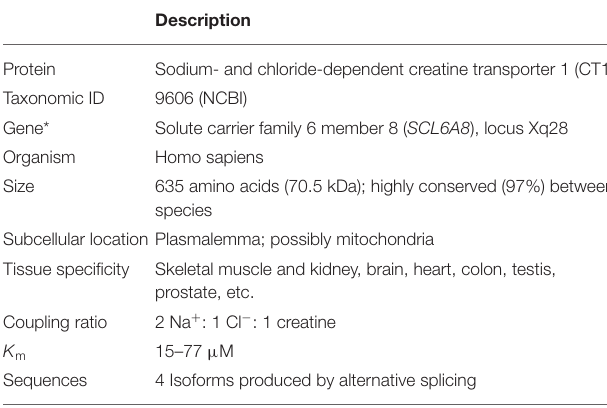
TABLE 1 | Basic structural and functional characteristics of the creatine